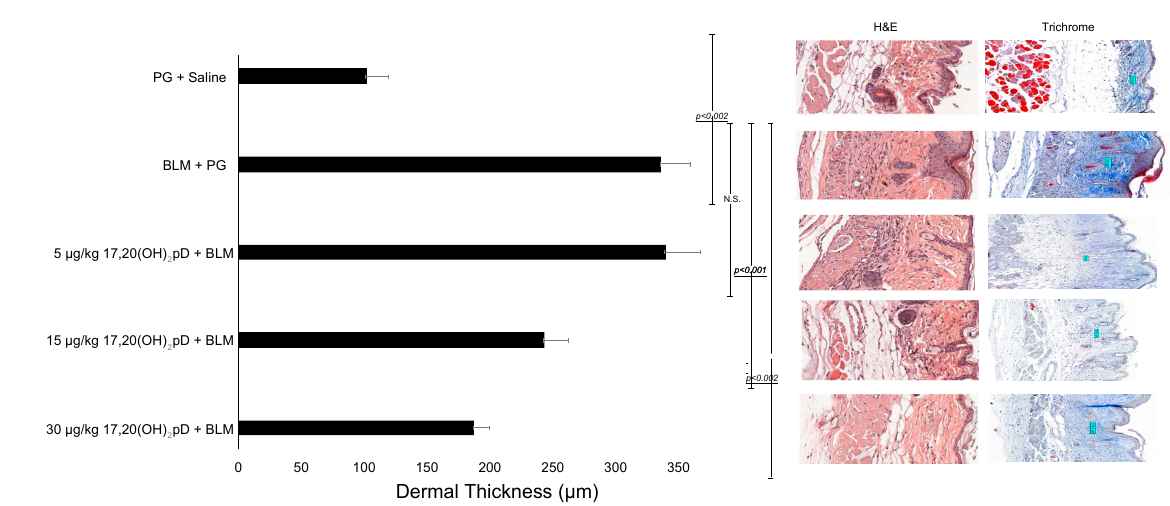
Figure 1. 17,20S(OH) 2 pD decreases dermal thickness in BLM model of fibrosis. C57BL/6 mice ( n = 6 per group) received oral gavage daily with either vehicle (100 µ L propylene glycol 1:5 diluted PG) or 17,20(OH) 2 pD at either 5, 15, or 30 µ g/kg per 100 µ L of 1:5 diluted PG for 21 days. The skin was injected s.c. with either bleomycin 50 µ g per 100 µ L saline or 100 µ g saline daily for 21 days, then extracted for histology and collagen synthesis. p values were determined by ANOVA; p < 0.05, significant. Left panel: quantification of the dermal thickness; middle panel: H&E stained sections; right panel: Trichrome stained sections. All are 20 × magnification.